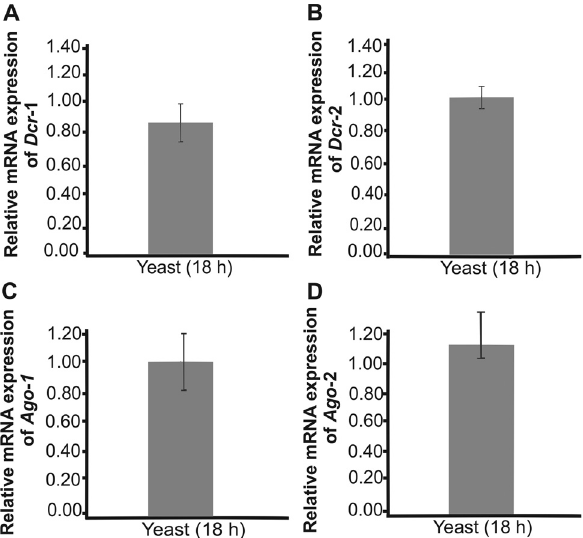
Figure 2 - Genes involved in the processing of microRNAs-like are in- duced in the parasitic phase of P. brasiliensis . Quantitative RT-PCR was performed with transcripts of Pb18 yeast cells cultivated in liquid Sabouraud medium for 18 hours. Expression values of genes involved in theprocessingofmicroRNAs( dcr-1,dcr-2,ago-1,ago-2 )werecalculated using actin as the endogenous control. Data are expressed as mean (cid:4) stan- dard deviation from